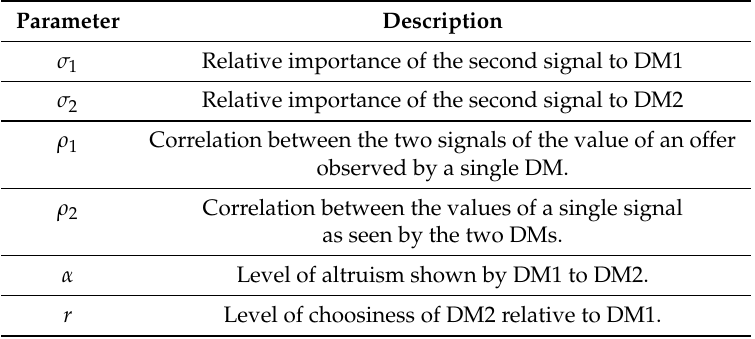
Table 1. Summary of the Parameters Used in the Game Theoretic